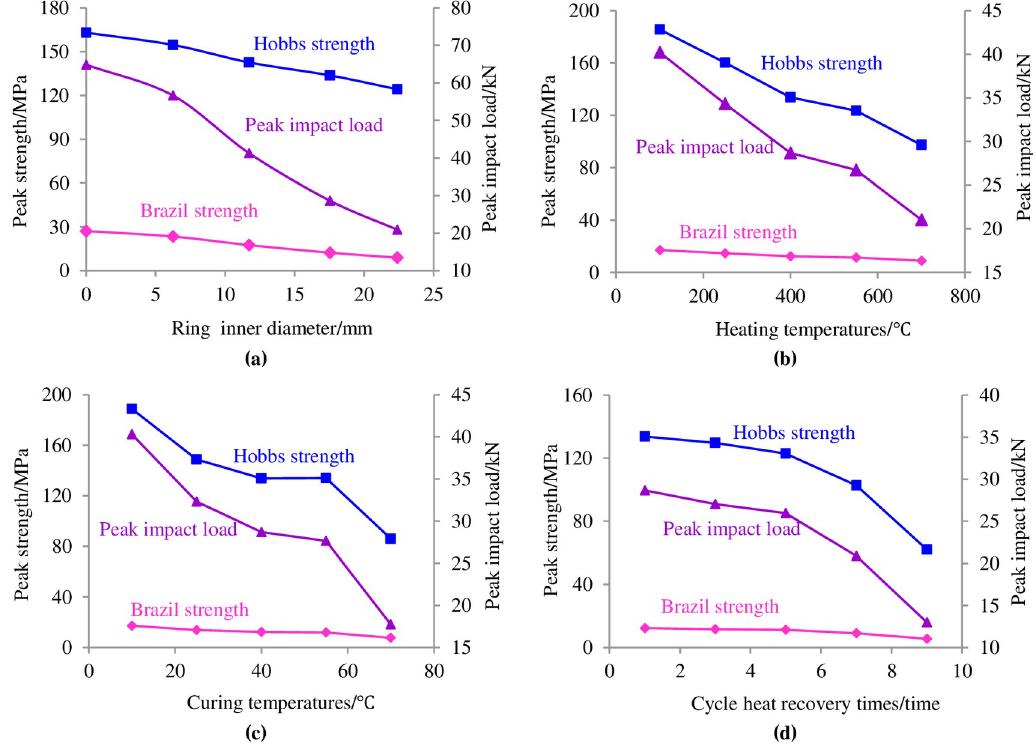
Fig 5. Changing relationships of the Hobbs intensity, Brazil strength and peak impact load. (a) Different ring inner diameter. (b) Different heating temperatures. (c) Different curing temperatures. (d) Different cycle heat recovery times.